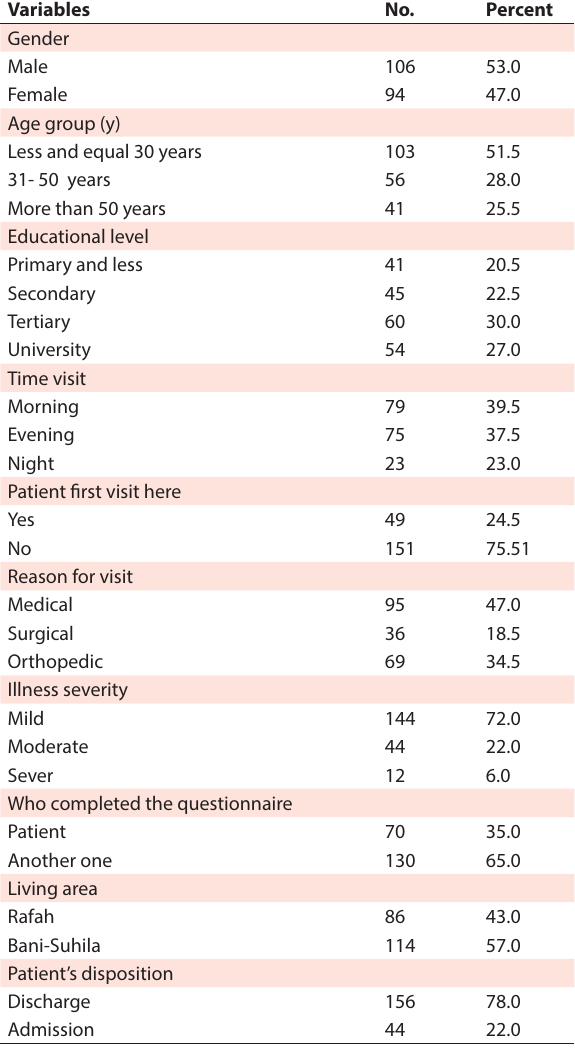
Table 1. The demographic, socio economic and health characteristics of patients (n = 200)